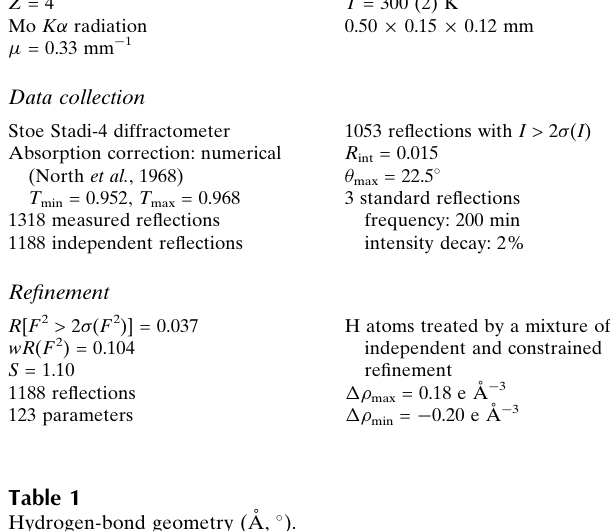
Stoe Stadi-4 diffractometer Absorption correction: numerical